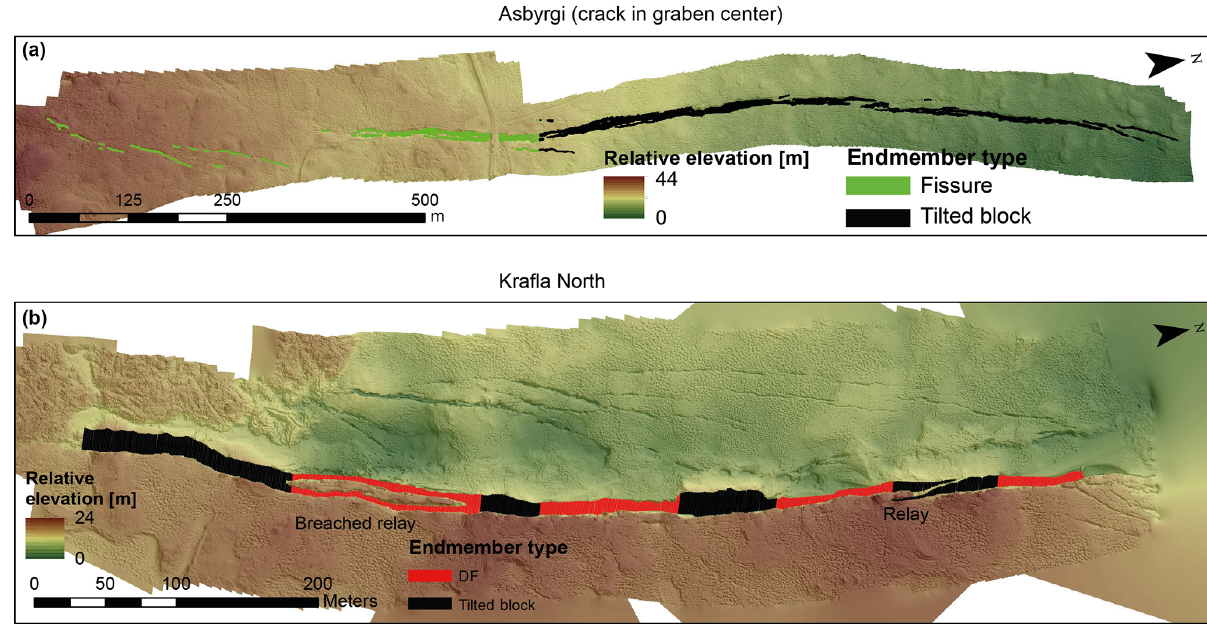
Figure 17. (a) DEM and proposed endmember types of the fractures close to Ásbyrgi canyon. (b) DEM and proposed endmember types of the fractures of the Krafla fissure swarm. Projection of the DEM: WGS1984 UTM